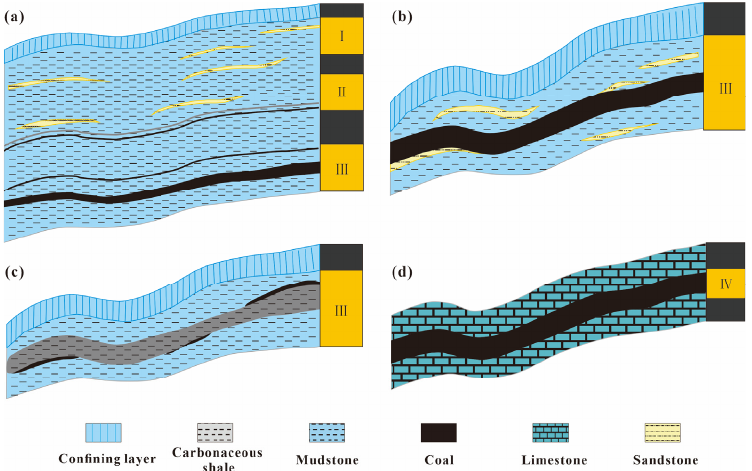
Figure 8. Identification and division of the gas-bearing system in the study area. ( a ) Far-source preservation enrichment; ( b ) near-source migration enrichment; ( c ) in-source shale gas